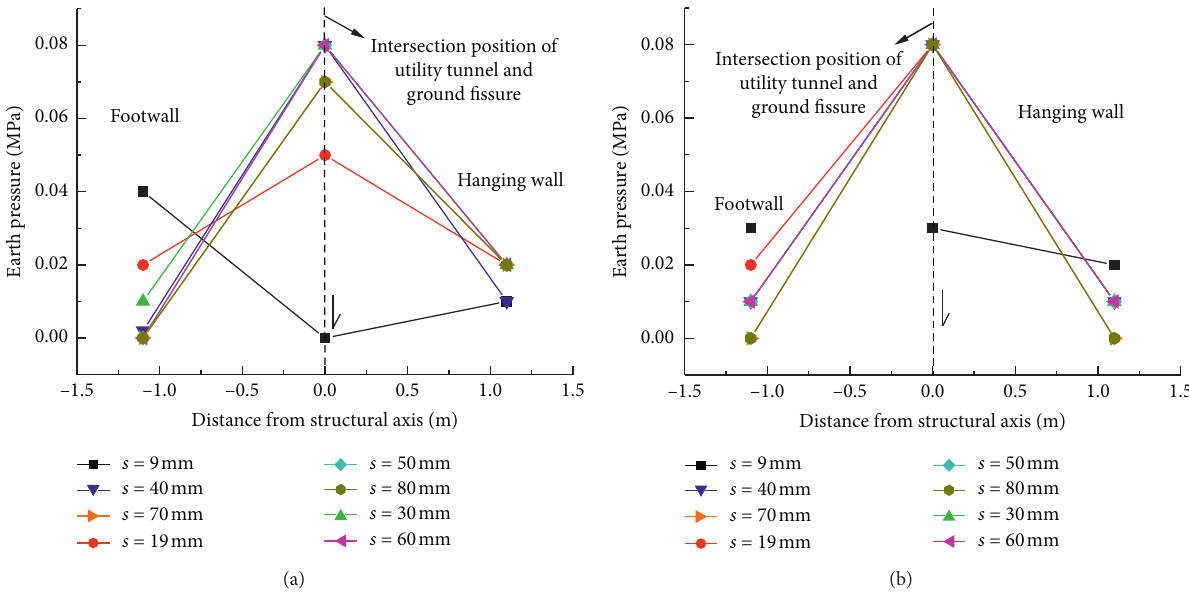
Figure 11: Transverse earth pressure curve on top of structure. (a) Transverse earth pressure curve on top of structure from the intersection of the ground fissure and the axis of the utility tunnel structure to the hanging wall at 0.8m. (b) Transverse earth pressure curve on top of structure from the intersection of the ground fissure and the axis of the utility tunnel structure to the footwall at